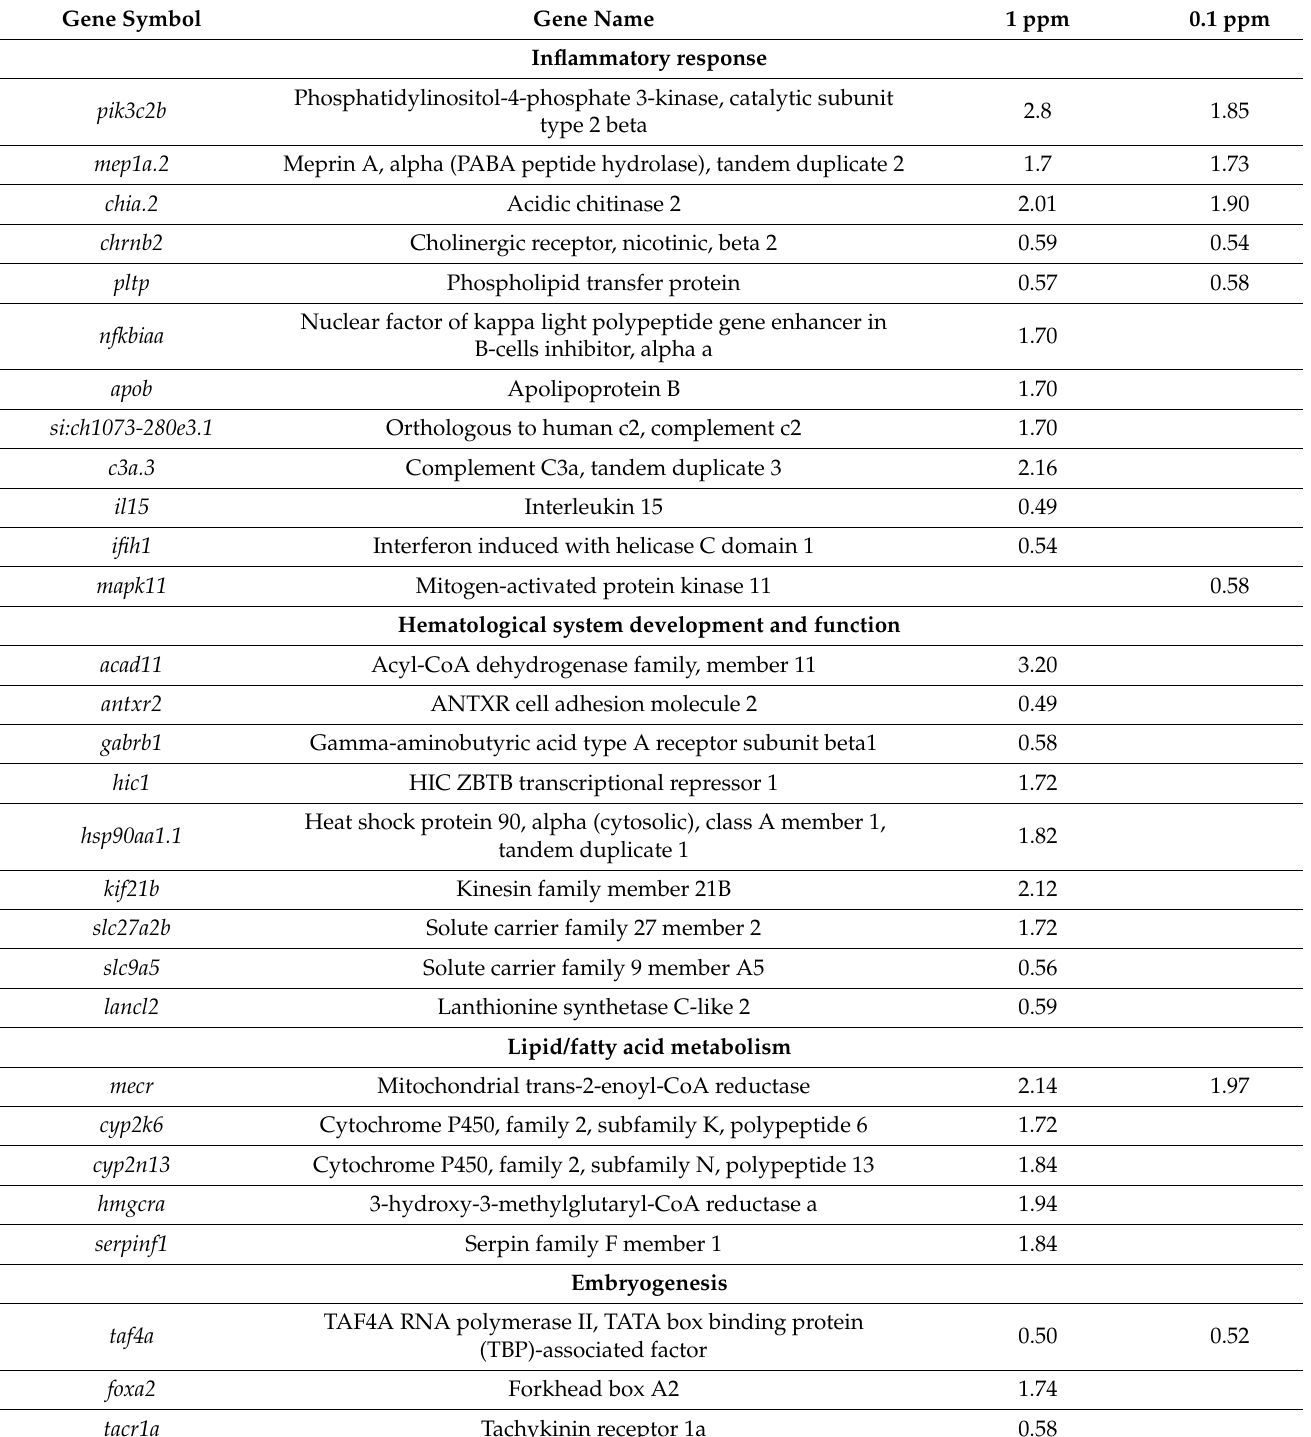
Table 1. Dysregulated genes of benzene exposure based on gene expression fold changes relative to unexposed